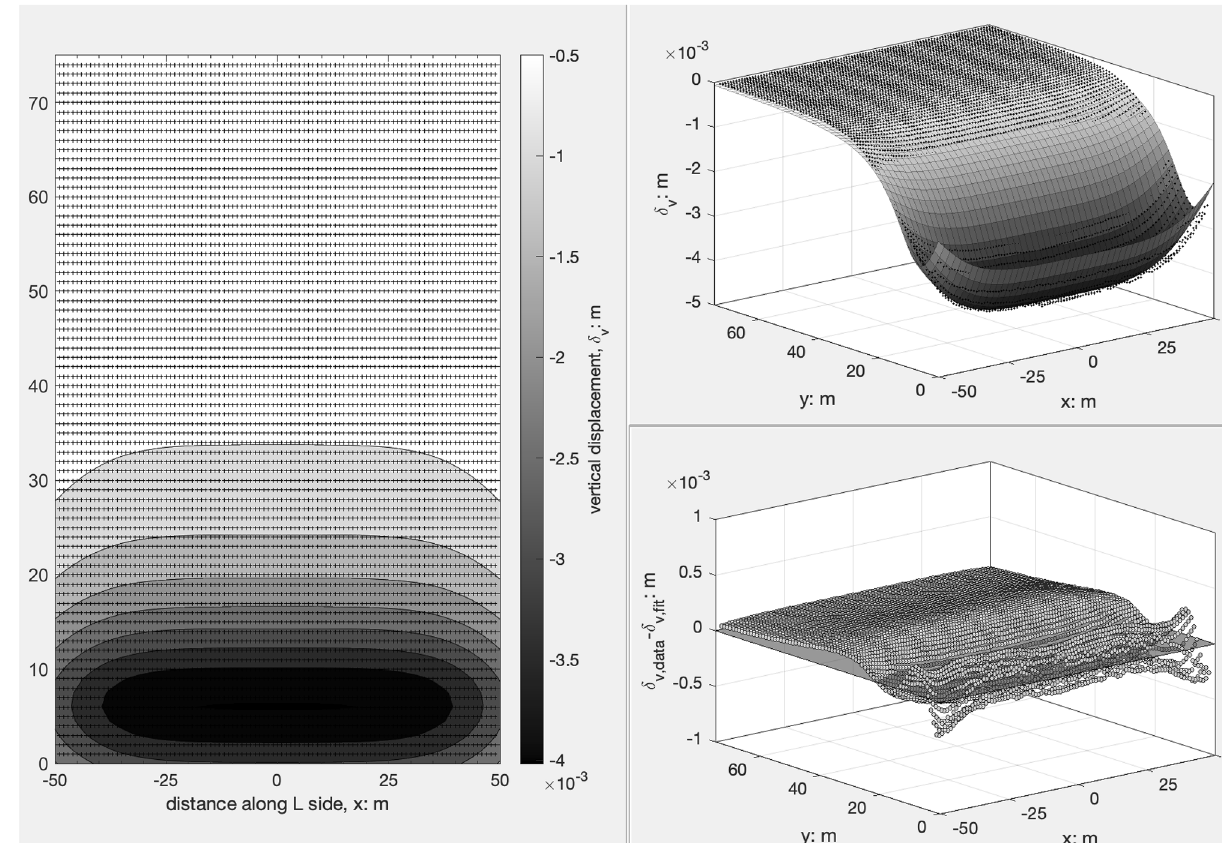
Figure 12. Fitted surface, comparison between fitted and computed settlement and residuals distribution (case